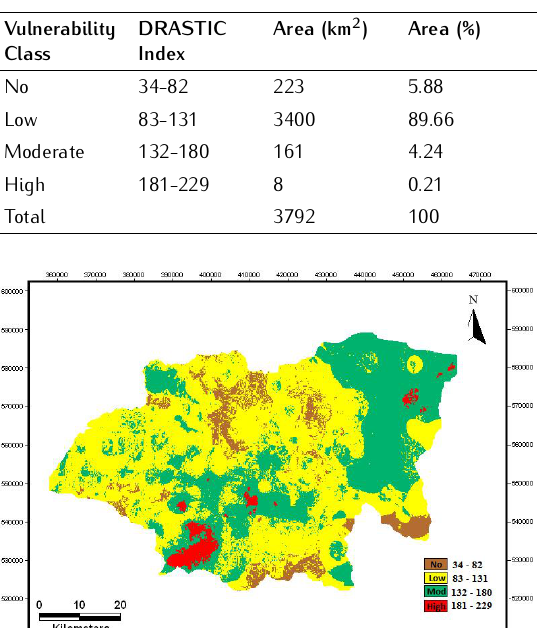
0.11% of AZB (Table 8 and Figure 12).